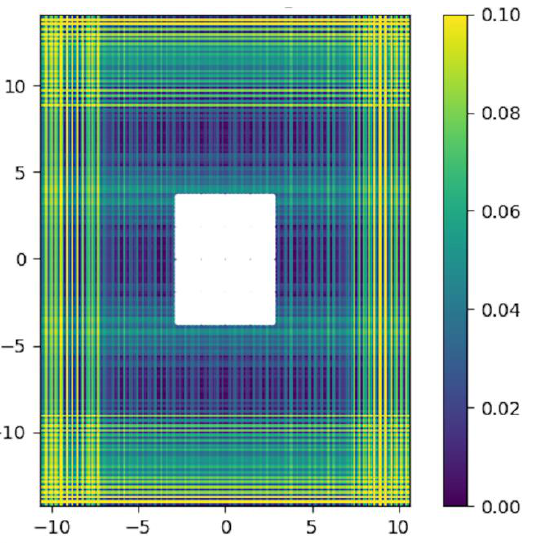
Figure 5. The distribution of errors is color coded graphically for a chosen depth of 10 cm and an area of 400%. The white square in the center corresponds to the surface of the PC.